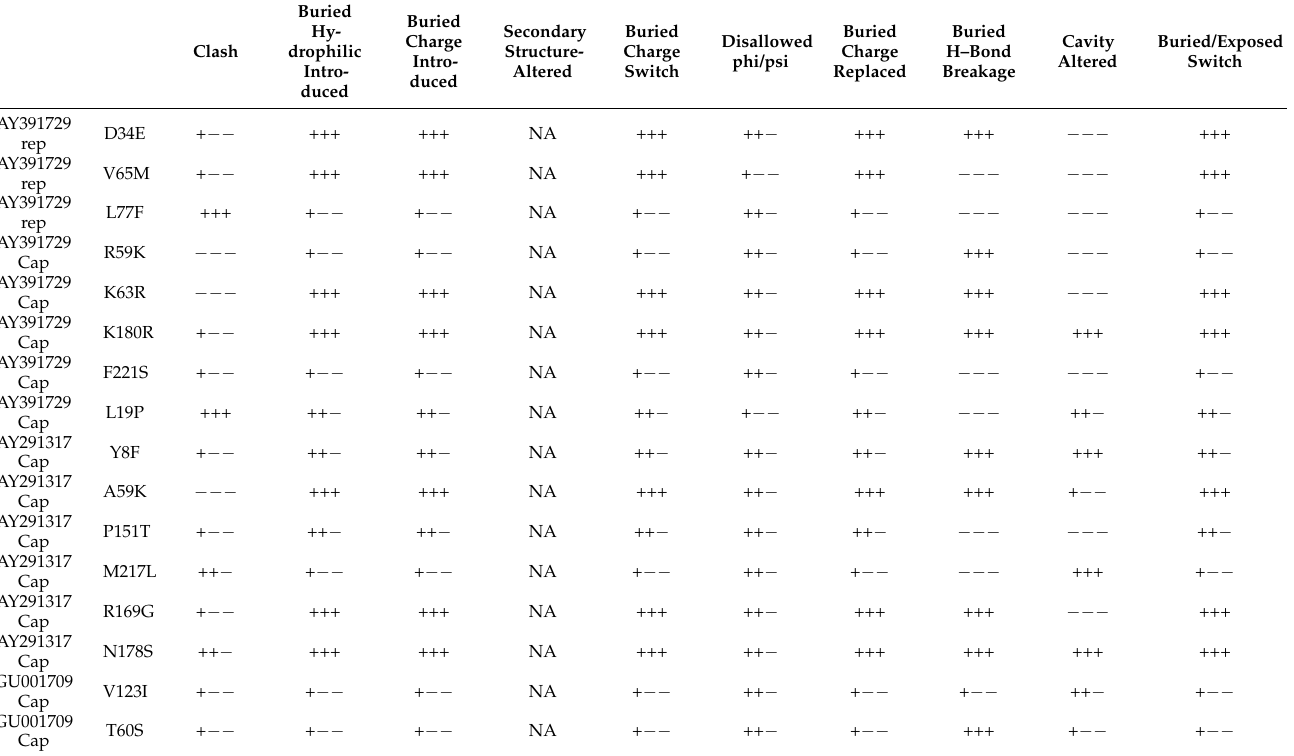
Table 3. Effect of mutations on the secondary structure of the Cap and Rep